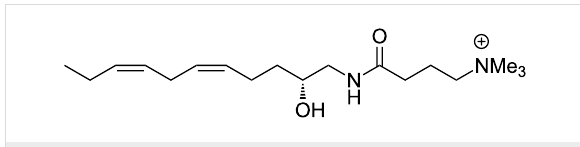
Figure 1: Structure of ( R )-( − )-complanine.